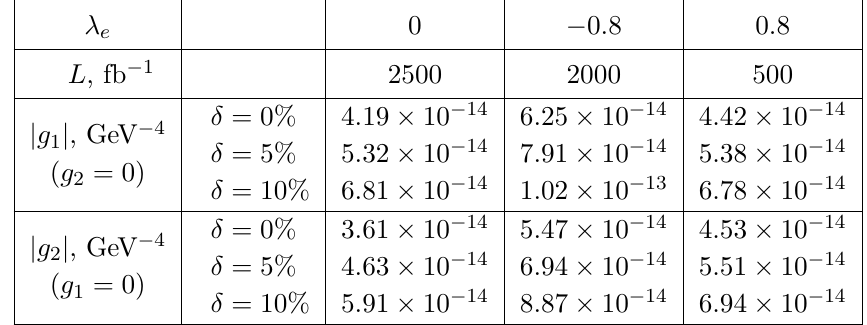
Figure 5 . The same as in figure 4, but for the e + e − collider energy sets g 1 = 10 − 13 GeV − 4 , g 2 = 0 , and g 1 = 0 , g 2 = 10 − 13 GeV − 4 .